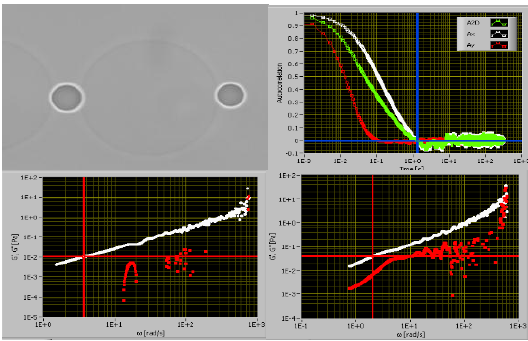
autocorrelation function generated, and fig. 2 (c and d) a comparison of moduli calculated for a free bead and an entrapping bead.